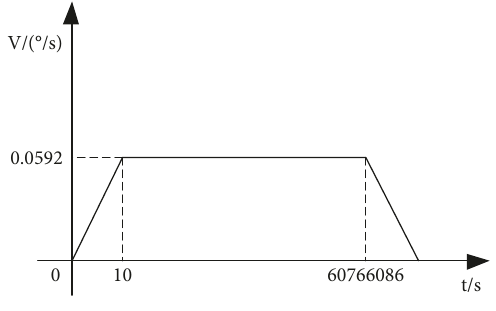
Figure 25: Planned velocity of the attitude